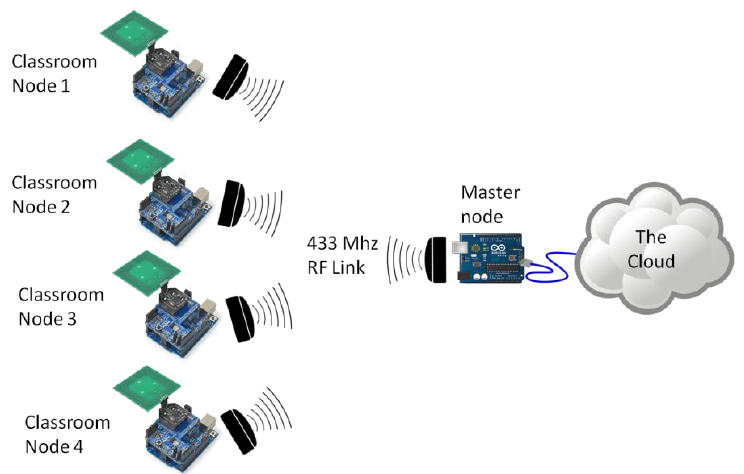
Figure 2. System communication scheme.